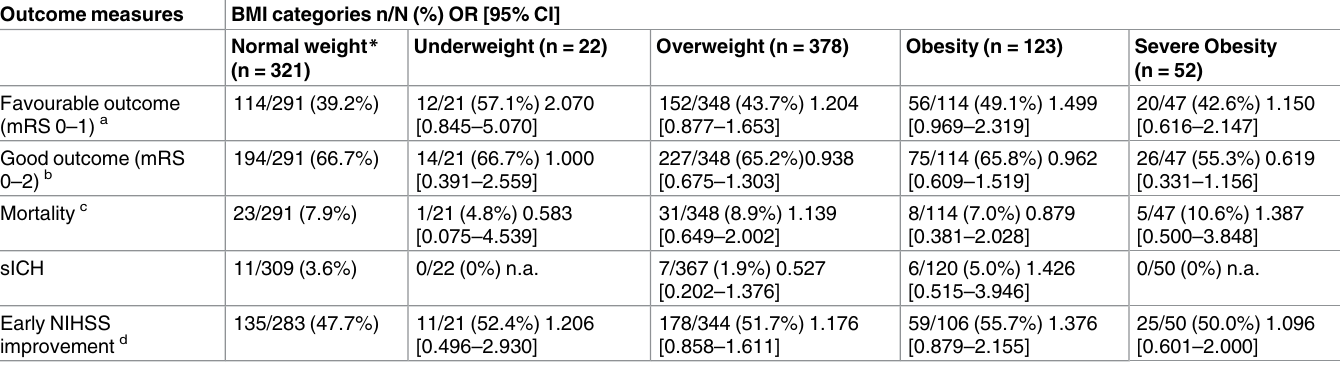
Table 2. Univariate outcome analyses according to BMI categories.